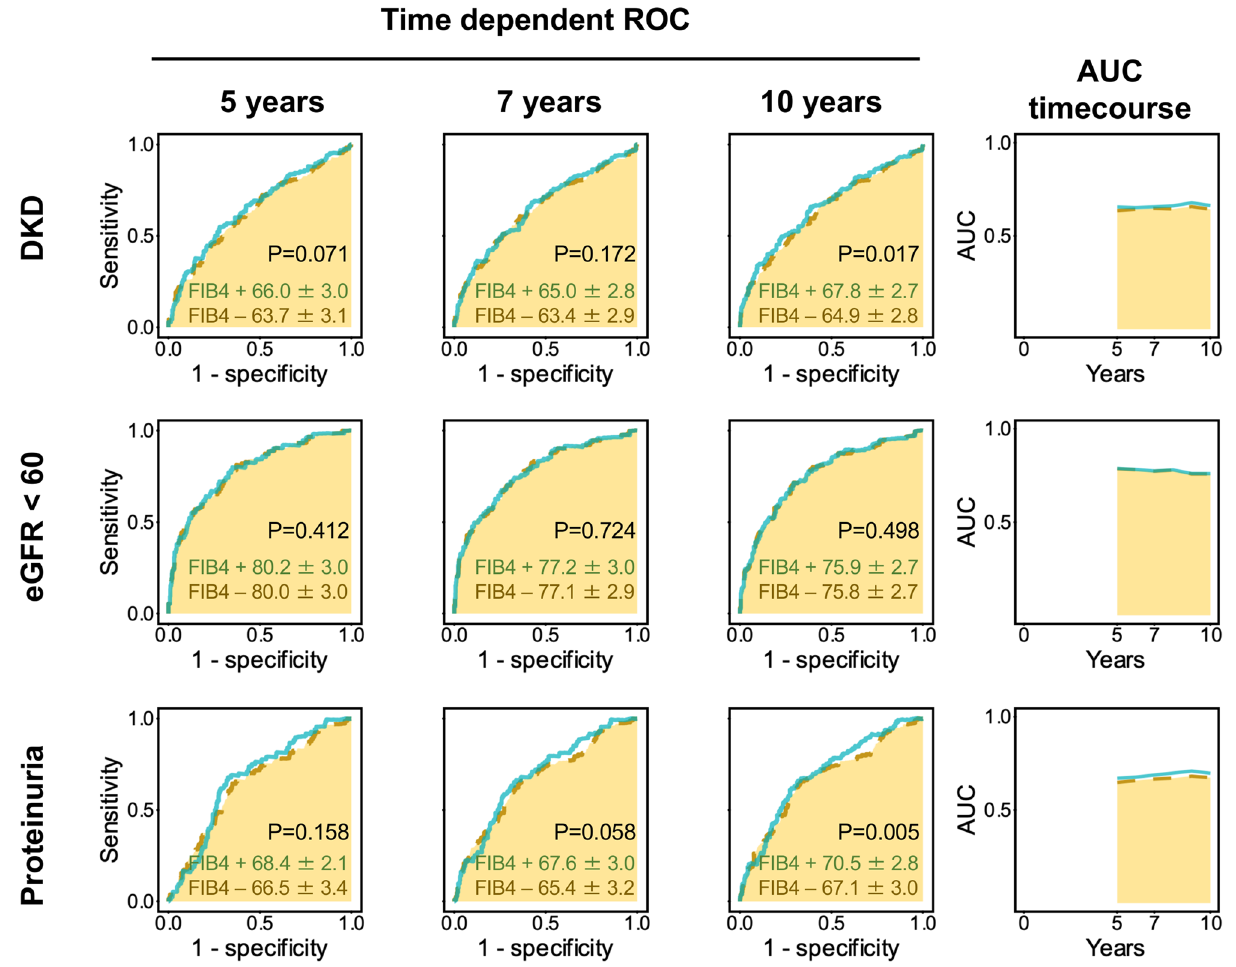
Figure 5. Time dependent receiver operating characteristic curve (ROC) analysis of FIB4 index for development of DKD, eGFR and proteinuria. Models included with or without FIB4 index were anlyzed by area under the curve (AUC) of ROC analysis. Model covariants except FIB4 index included age, sex, BMI, baseline HbA1c, baseline eGFR, smoking and drinking status (current or past), comorbidities (hypertension, dyslipidemia) and anti-diabetic and anti-hypertensive medications. P values were for comparisons between model with or without FIB4